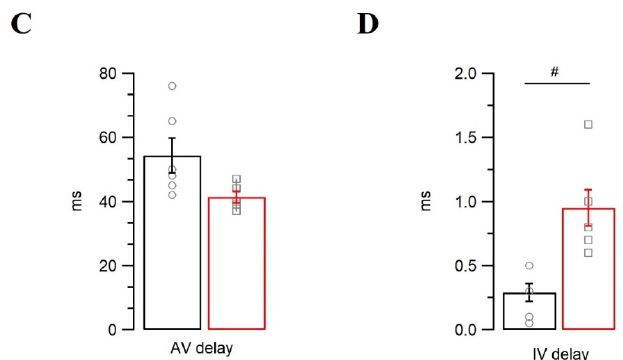
Figure 5. Intracardiac electrocardiogram recordings on WT and Trpm4 −/− explanted hearts. ( A ) Representative pseudo (P.ECG) and intracardiac (IC.ECG) ECG trace from a WT heart. A and V respectively represent atrial and ventricle signals from the intracardiac catheter recorded in different electrode channels (CH 1-7). Conduction delays either between the atria and ventricle (AV delay, CH 6-5) or intraventricular (IV delay, CH 4-1) were measured as the time delay between respective channel signals. Representative trace showing signal derivatives from CH 1 and 4 to measure IV delay ( B ). Average AV delay ( C ) and IV delay ( D ), compared between the genotypes (WT: circle, black and Trpm4 −/− : square, red). Note: N = 6, #: p < 0.05, WT vs. Trpm4 −/− ; ns = not significant.